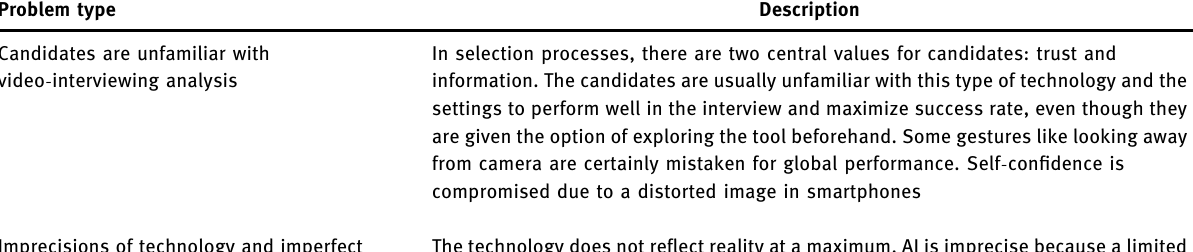
Table 2: Problem types of image analysis in video interviewing Problem